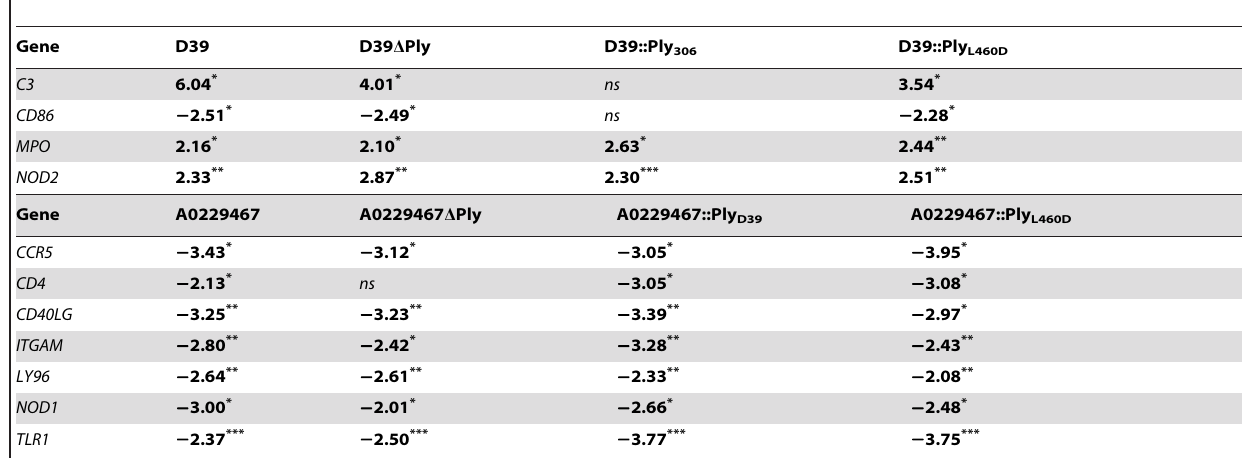
Table 3. Strain-dependent Ply-independent changes in expression relative to resting.